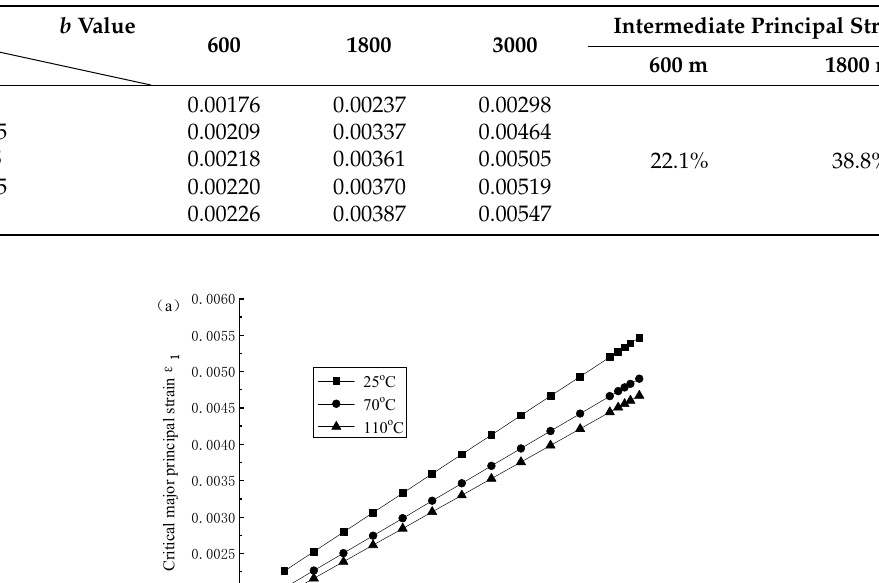
Table 4. The critical collapse major principal strain with the same wellbore depth under different b values.